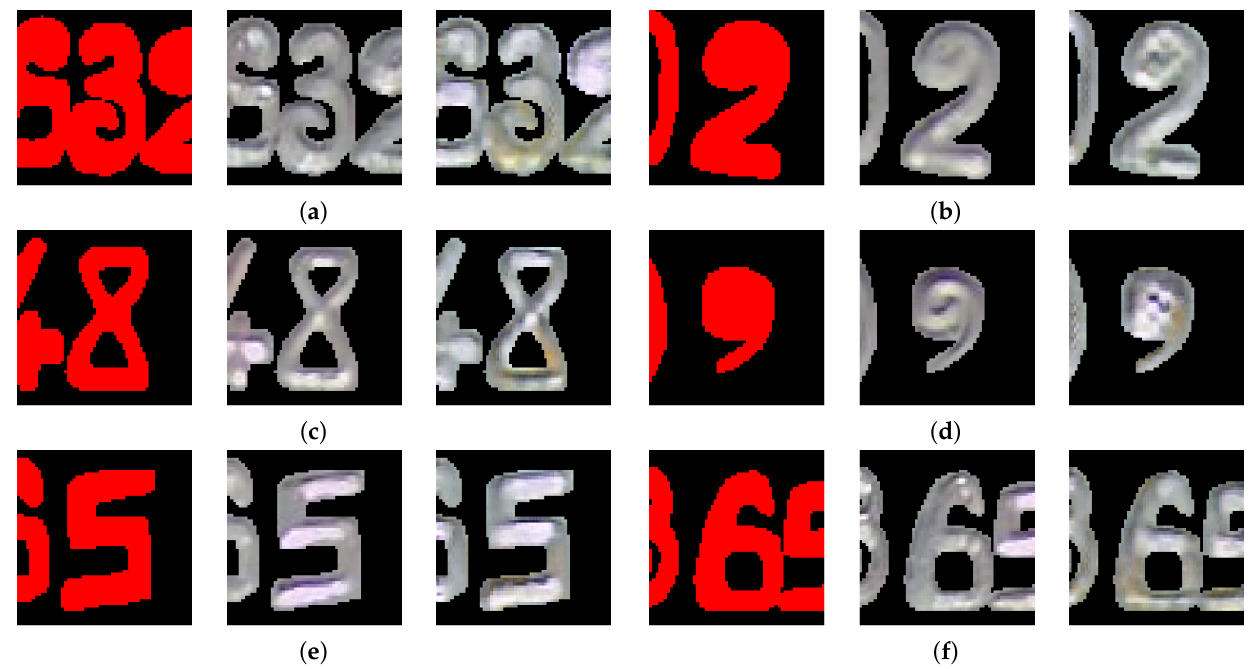
Figure 4. Results of the cGAN generator with the input mask ( left ), original image ( middle ), and synthesis ( right ). ( a , c , f ) depict examples of the GAN hallucinating rust onto a generated digit, ( b , d ) are examples where artifacts can be seen on the generated image, ( e ) is an example where the generated image is highly similar to the real image, without serious hallucinated additions or